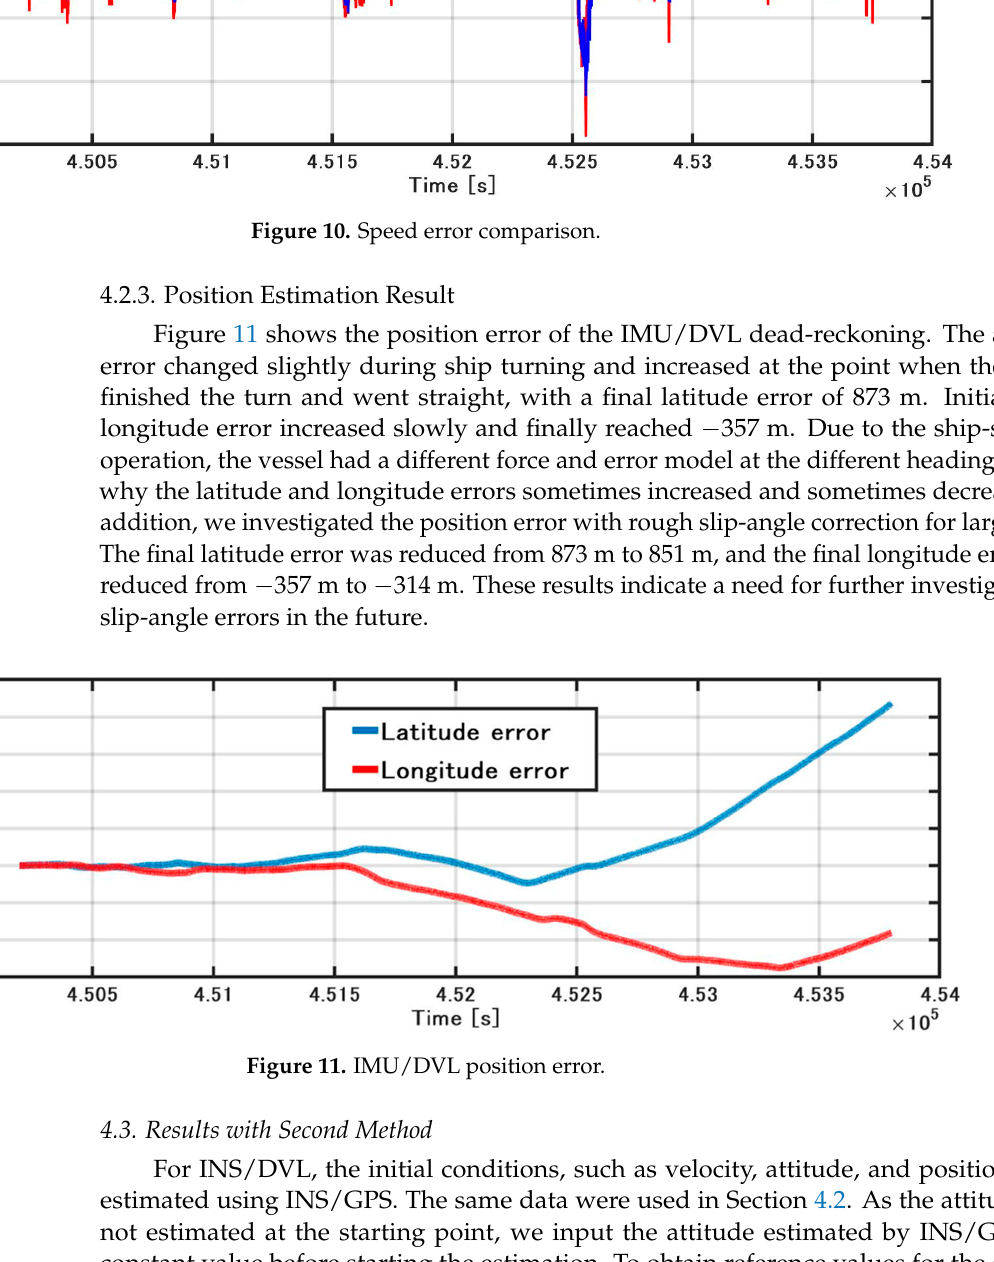
Figure 9. Speed comparison.